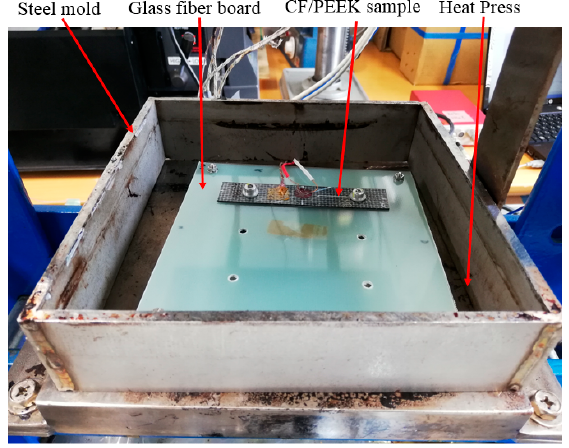
Figure 17. Strain gauge orientation with respect to fibre direction for three different scenarios.